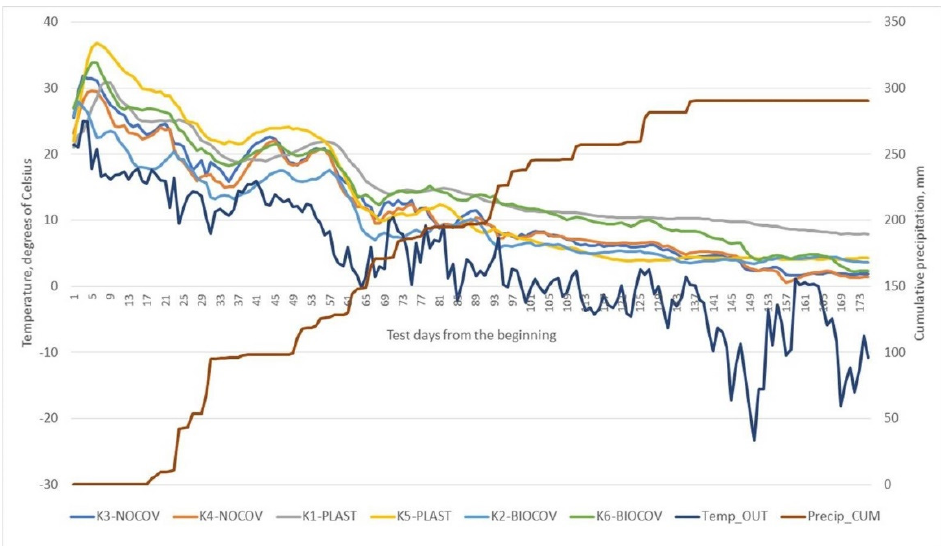
Figure 5. Temperature development in the experiment within piles during the storage of chips for the different cover alternatives of plastic (PLAST), uncovered (NOCOV) and the bio-pile cover (BIOCOV), along with the outside temperature (Temp_OUT) and the cumulative precipitation (Precip_CUM) on the secondary axis.